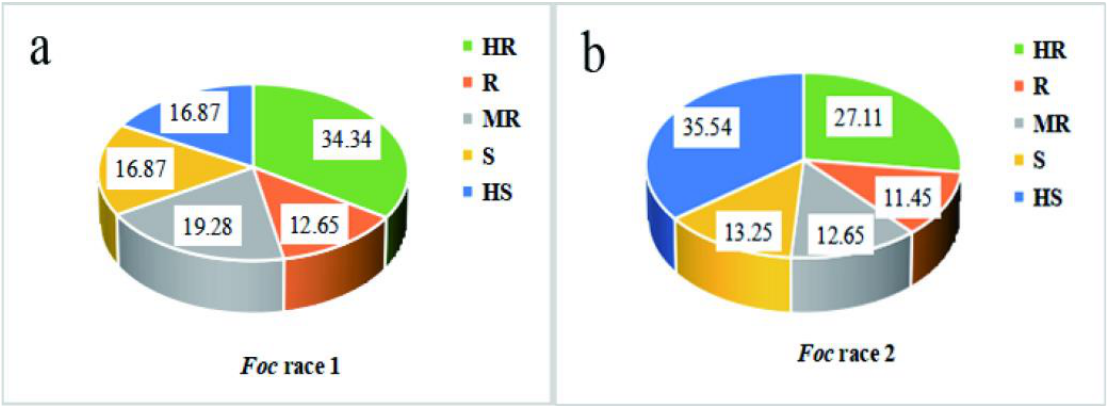
Figure 2. Proportion of resistance levels of different cabbage materials to Foc. ( a ) and ( b ) represent the proportion of materials with different resistance to Foc race 1 and 2. HR = highly resistant; R = resistant; MR = moderately resistant; S = susceptible; HS = highly susceptible.